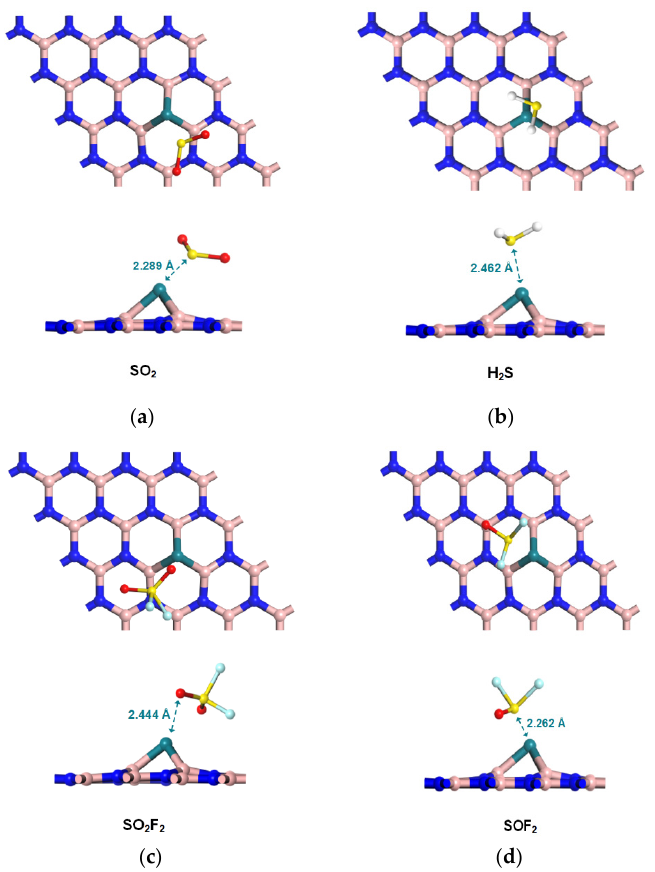
Figure 4. Configurations of gas adsorption systems: ( a ) SO 2 /Rh-VNBN adsorption system; ( b ) H 2 S/Rh-VNBN adsorption system; ( c ) SO 2 F 2 /Rh-VNBN adsorption system; ( d ) SOF 2 /Rh-VNBN adsorption system.